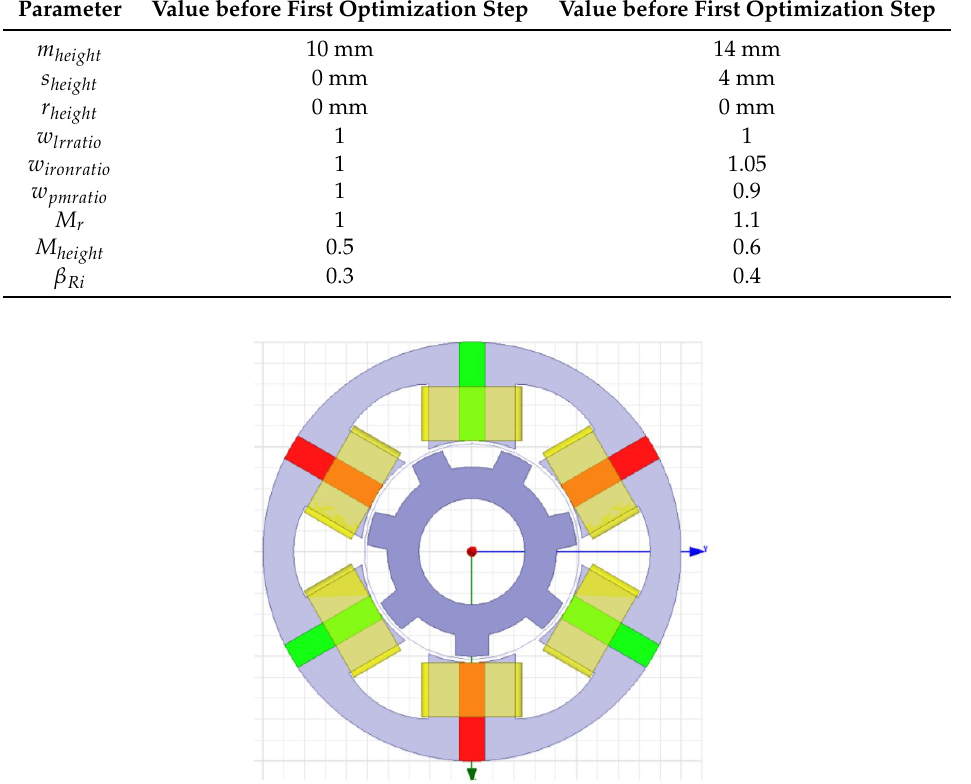
Figure 12. New optimized FSPM motor as illustrated in the FEM